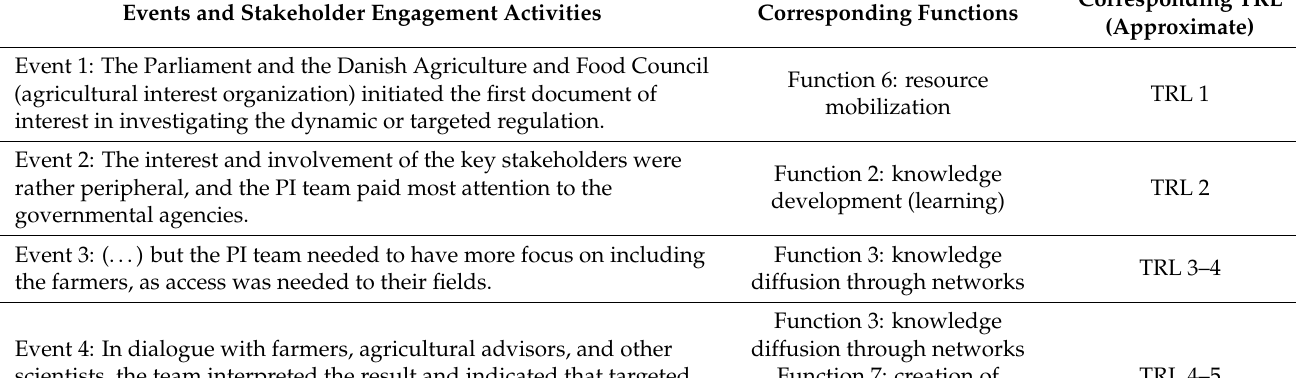
Table 2. The interplay of stakeholder engagement activities with the seven functions and TRL. Events and Stakeholder Engagement